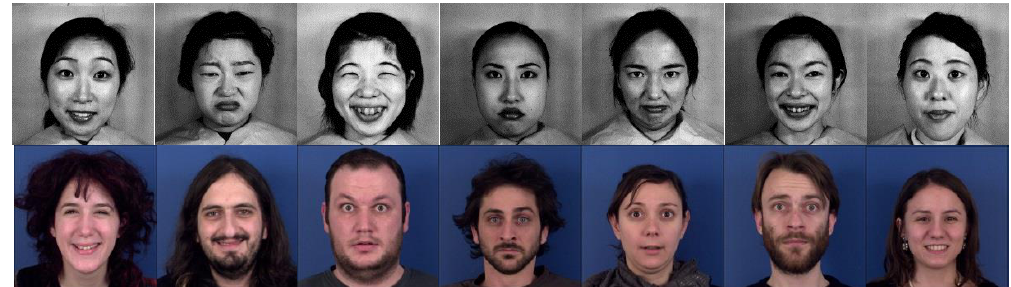
Figure 2. Images in the first row show some examples of JAFFE dataset and images in the second row are from the MUG dataset.